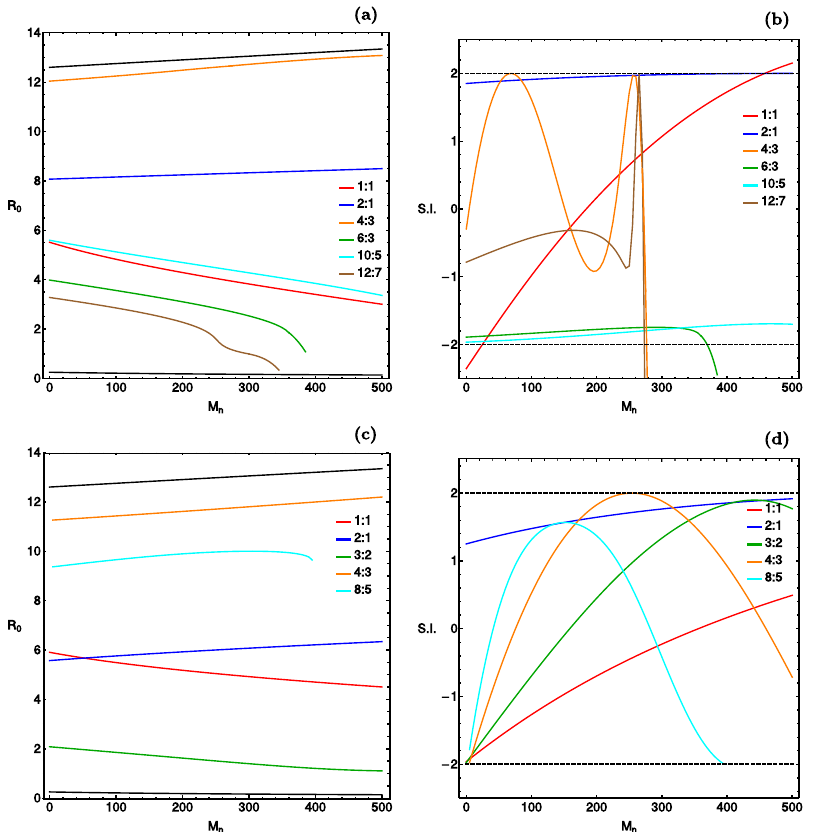
Fig. 1. Evolution of the R coordinate of periodic orbits as a function of mass of the nucleus, M n , for the PH models (panel a) and OH models (panel c), and the evolution of the stability index S.I. as a function of M n for the PH models (panel b) and OH models (panel